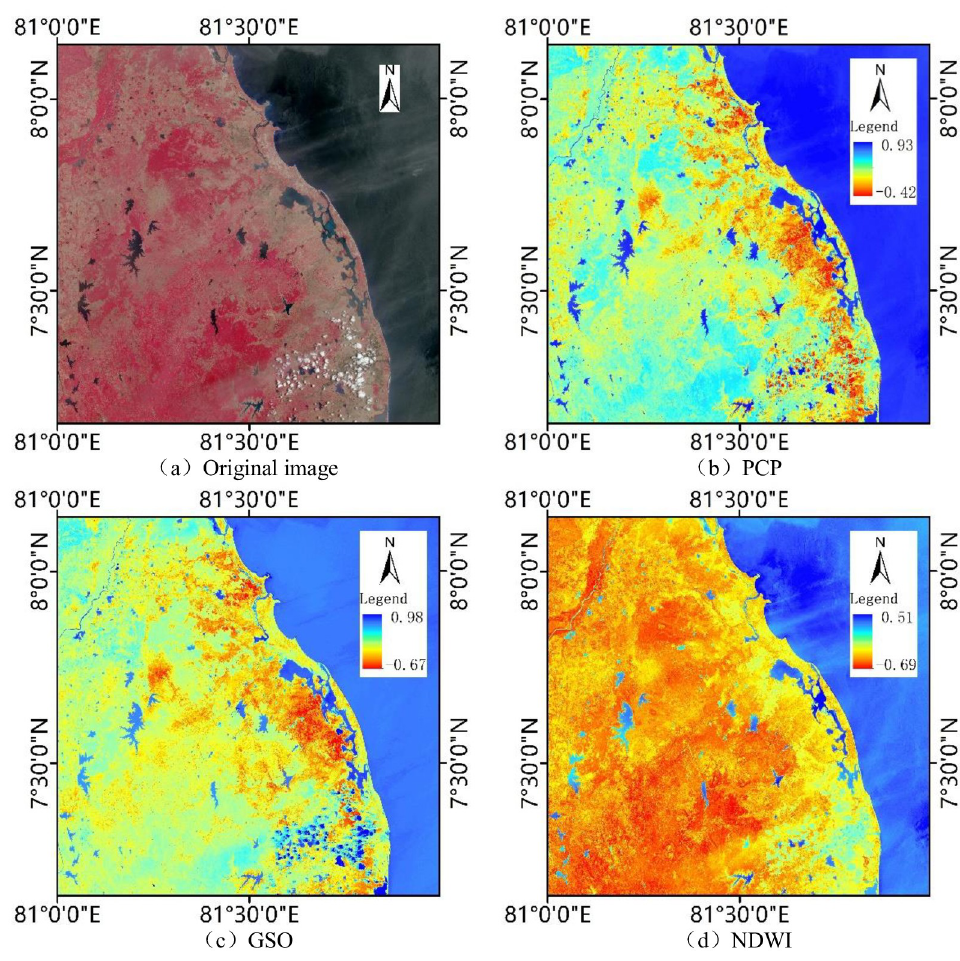
Fig 3. The original image, wetness component of the K-T transformation and NDWI of site2.